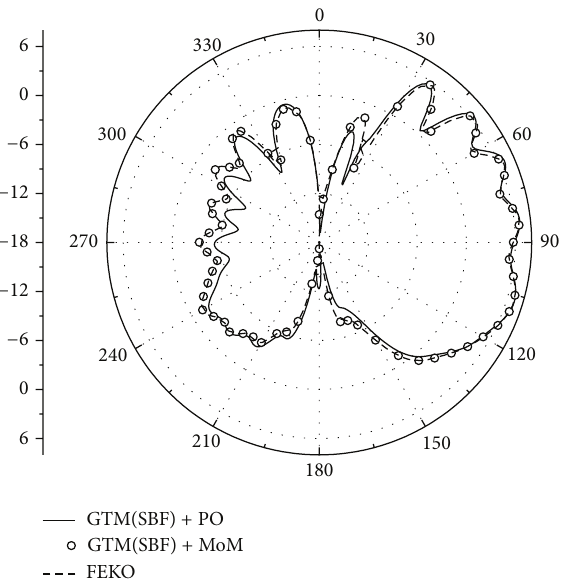
Figure 6: Radiation patterns in the xoz plane of the Vivaldi antenna element on a large PEC plate.